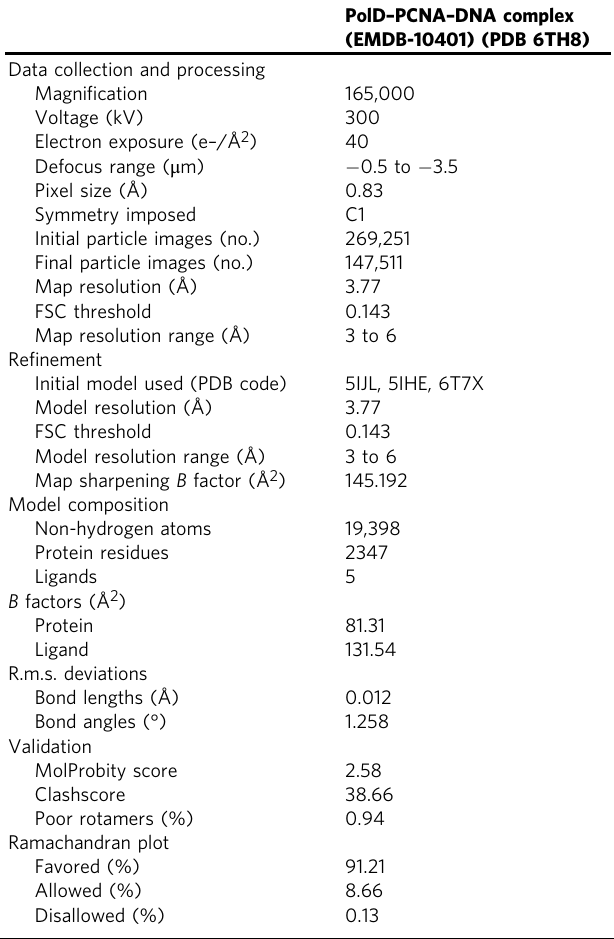
Table 1 Cryo-EM data collection, re fi nement, and validation